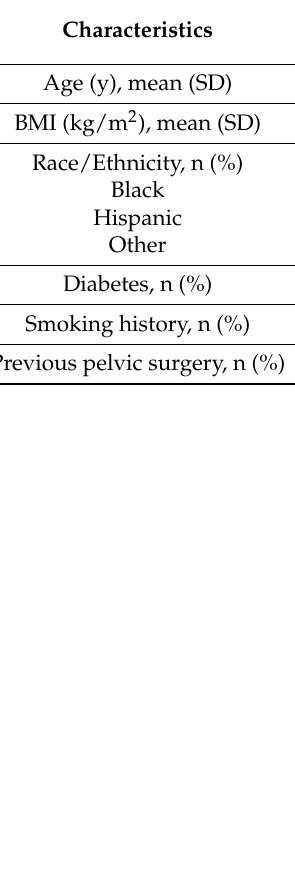
Figure 1. Patient flowchart with time of initial recruitment, BTX-A injection, and follow up.